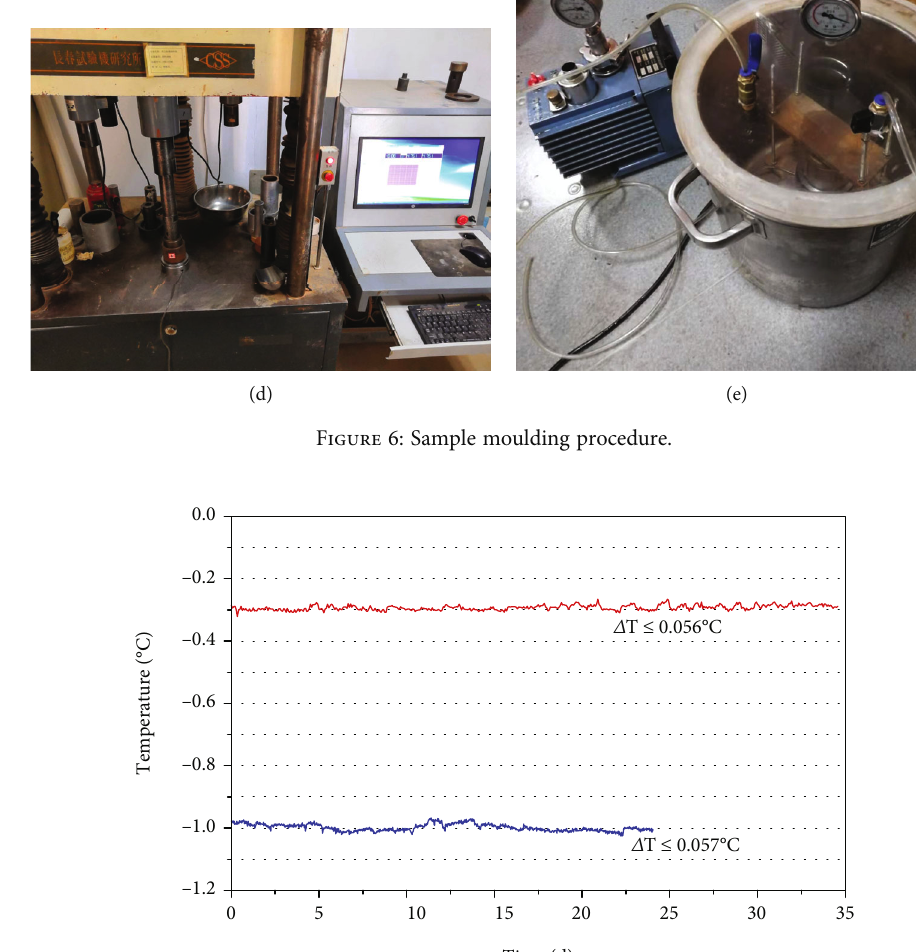
Figure 7: Temperatures variation in the